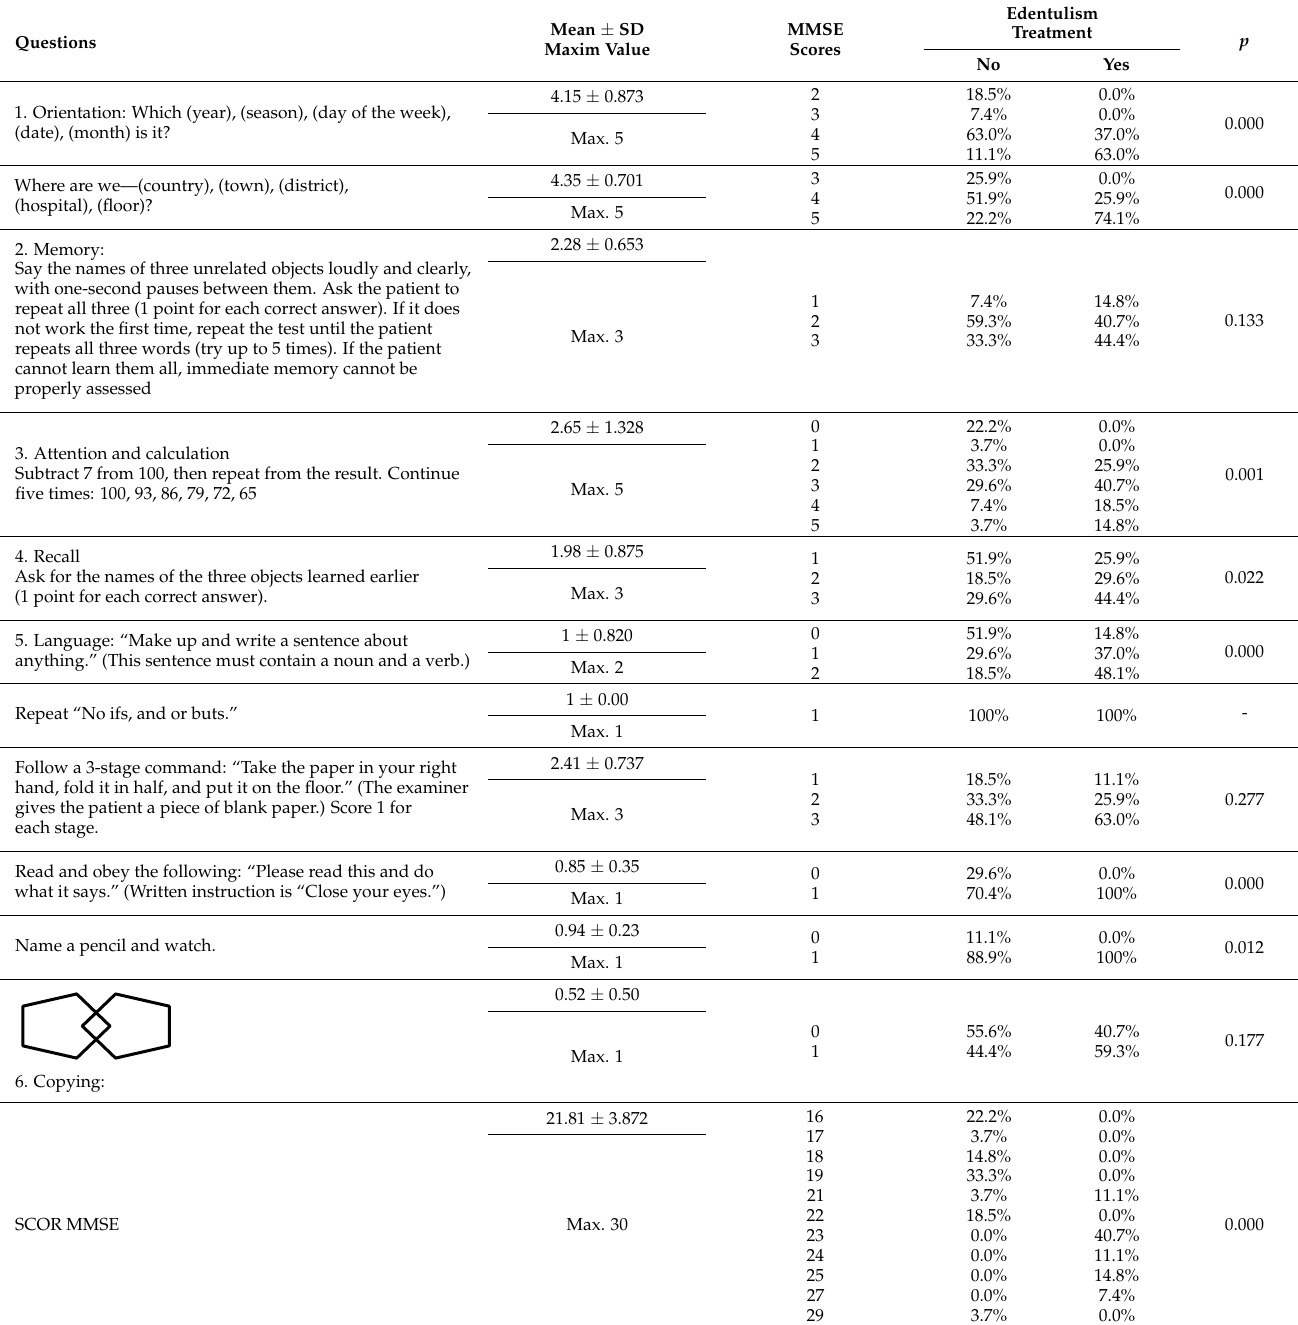
Table 2. Distribution of participants’ answers to the questions of the MMSE